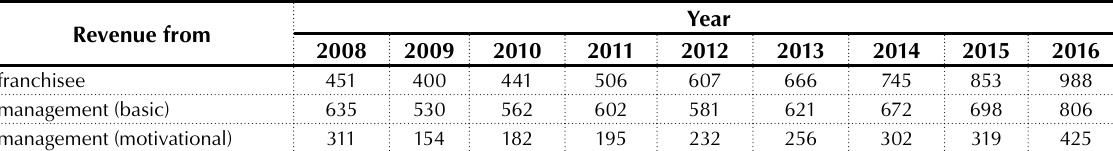
Table 2. Volume of revenue from different sources, 2008–2016, USD mln